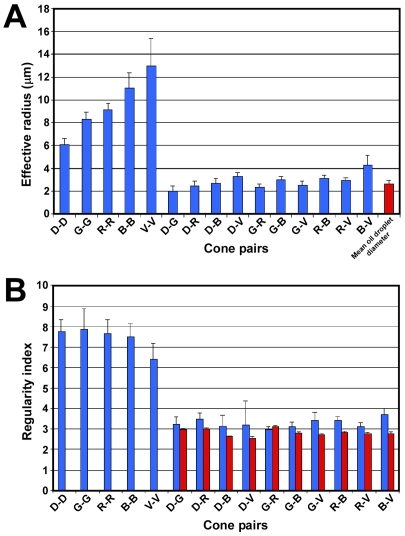
Cone mosaics are spatially independent.(A) Graph of the effective radius between cones of the same type (homotypic pairs) and different types (heterotypic pairs). Also shown for comparison is the average oil droplet diameter for all cone types. ‘D-D’, ‘Double cone-Double cone’; ‘G-G’, ‘Green cone-Green cone’ etc. Error bars are SD. (B) Graph of the nearest neighbor regularity indices for cones of the same type (homotypic pairs) and different types (heterotypic pairs) (blue bars). Also shown are regularity indices for simulated mosaics as described in the main text (red bars). Abbreviations are as in (A). Error bars are SD.